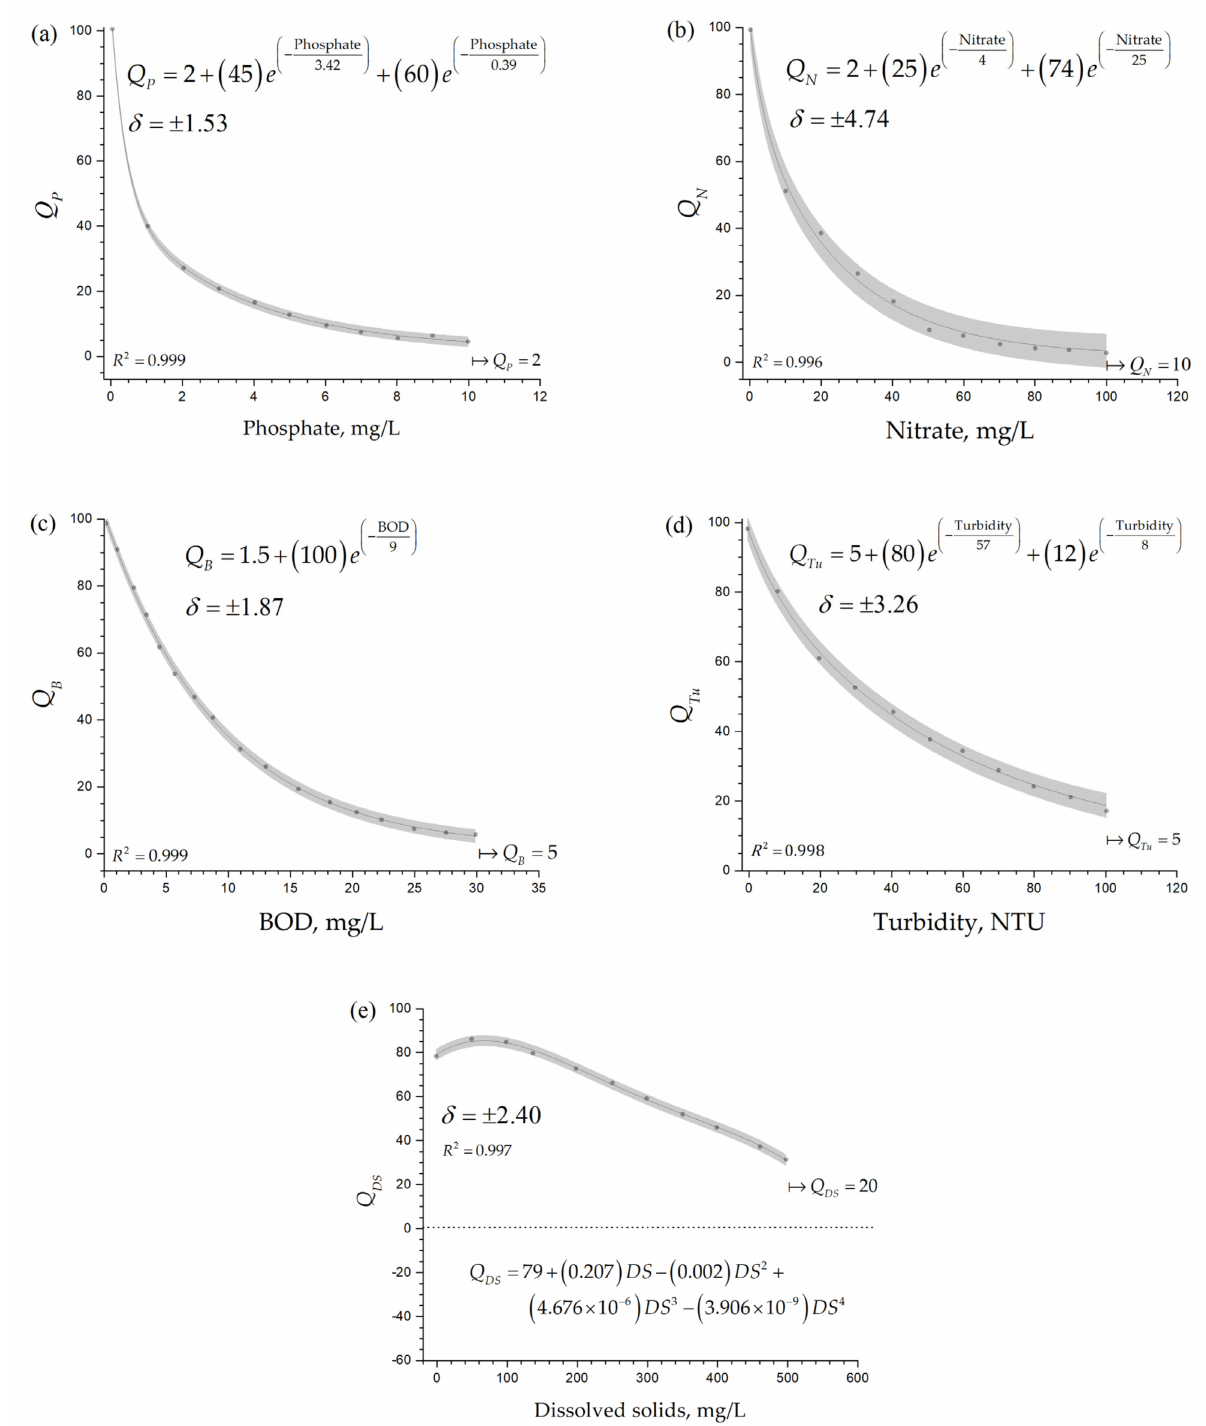
Figure 5. Analytical expressions and uncertainty in value prediction with a margin of 95% confidence for predictor variables utilized in WQI NSF estimations. Phosphate ( a ), Nitrate ( b ), Biochemical Oxygen Demand ( c ), Turbidity ( d ), and Dissolved Solids ( e